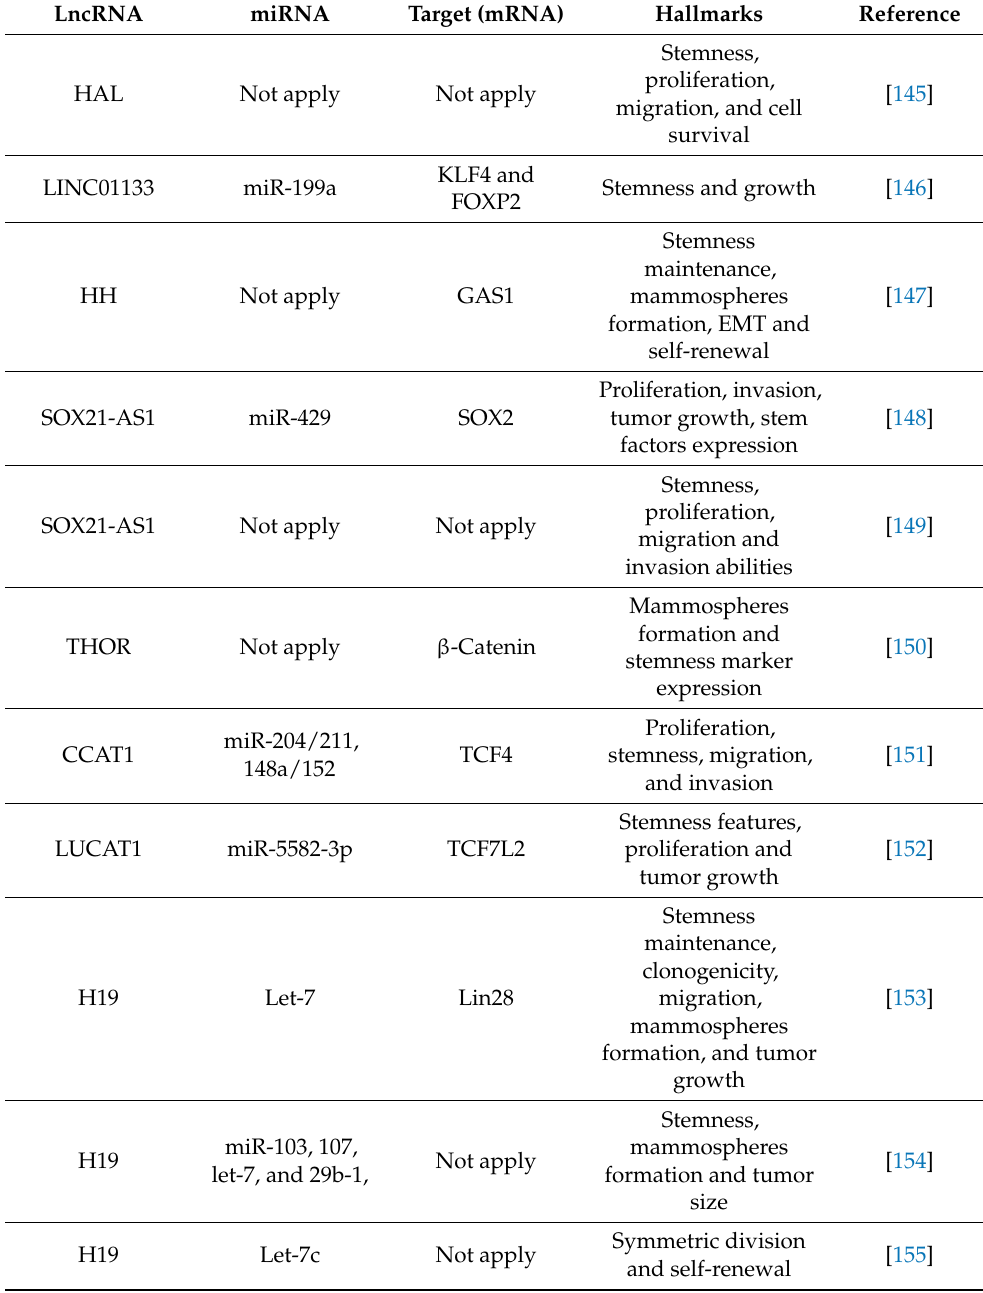
Table 3. Role of lncRNAs as gene regulators in